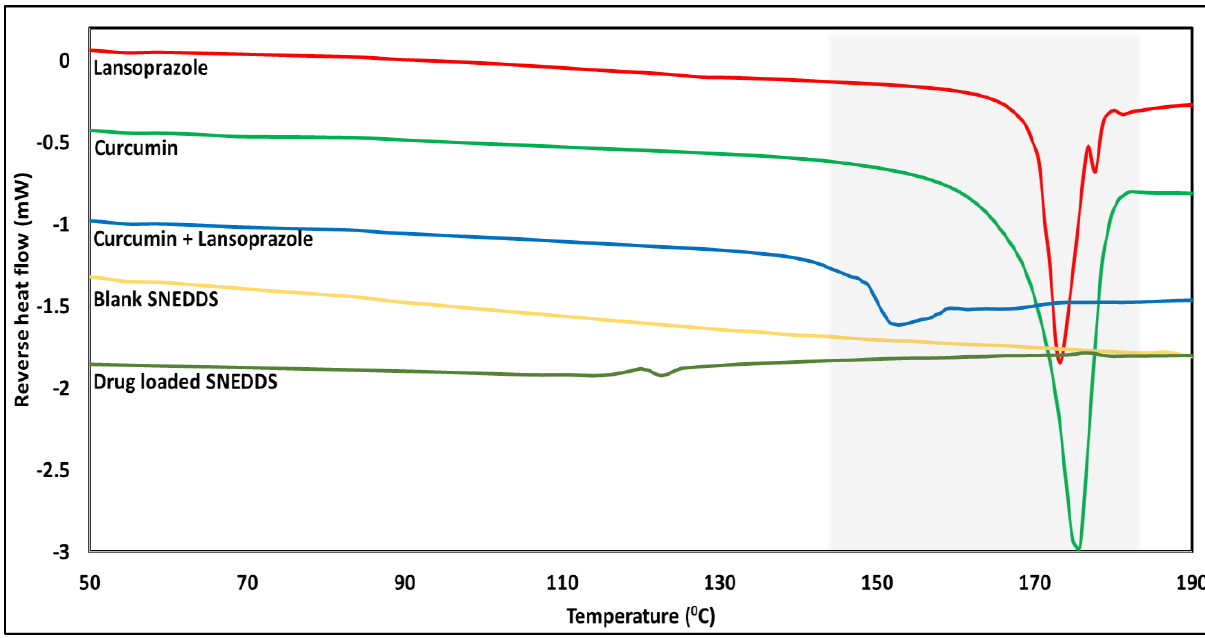
Figure 6. Modulated differential scanning calorimetry profiles for SNEDDS evaluation.